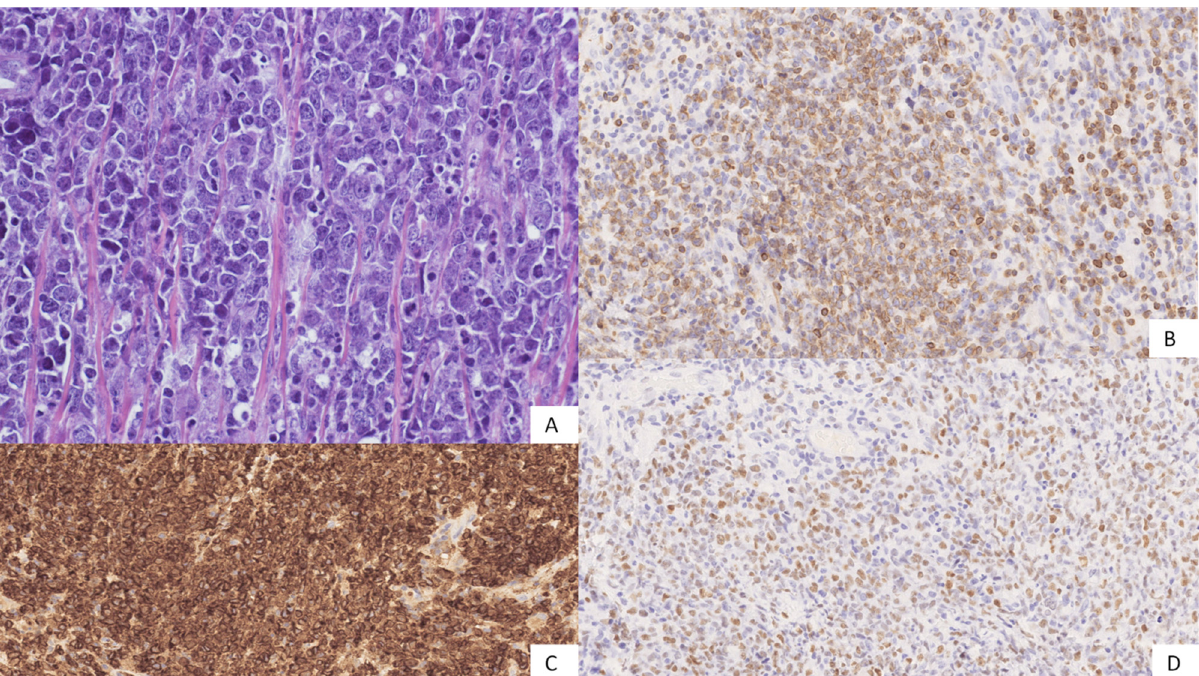
Figure 3. PCDLBCL LT. At histological evaluation, this lymphoma is composed of sheets of large, atypical cells (centroblasts and/or immunoblasts) with numerous mitoses and no/few reactive backgrounds (( A ), HE 40×). PCDLBCL ‐ LT frequently expresses bcl2 (( B ), 20×), IgM (( C ), 20×), and c ‐ MYC (( D ), 20×).